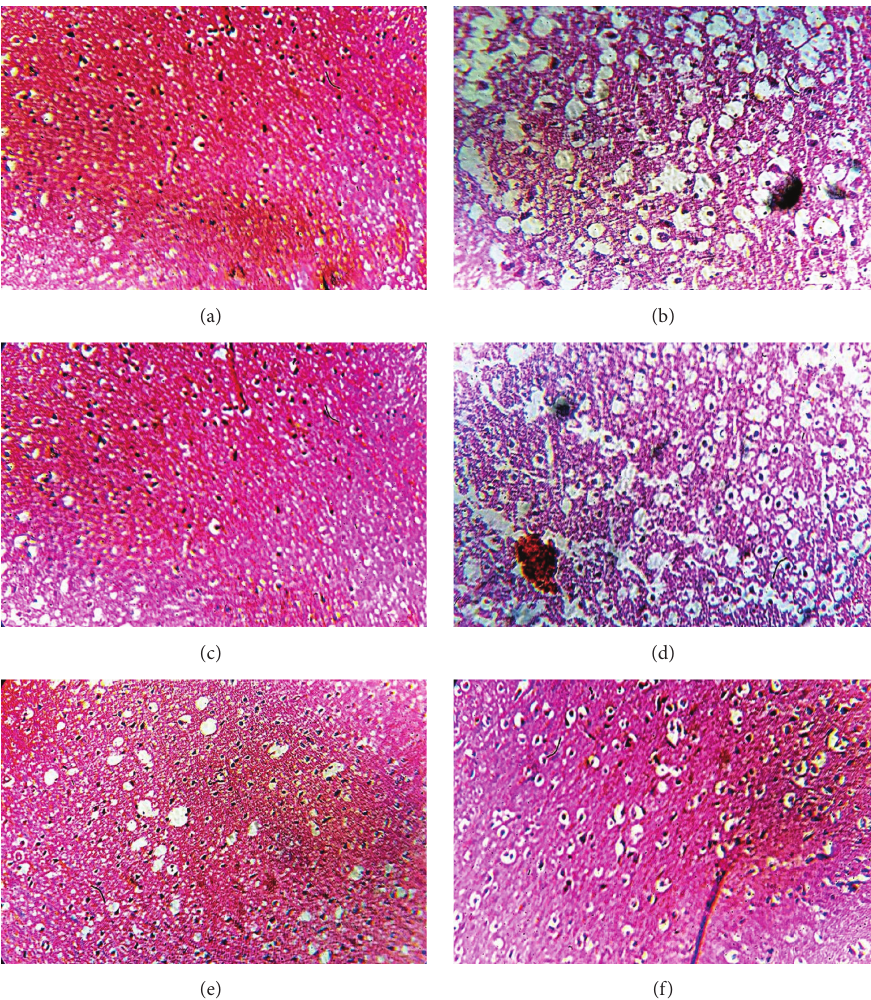
Figure 4: Effect of PEFRE on histopathological changes in the brain of normal and 6-OHDA treated animals (H&E staining; original magnification, 40x). (a) Normal control showing normal brain architecture. (b) Rats treated with 6-OHDA showing degeneration of neurons. (c) Rats treated with 6-OHDA and Levodopa (6mg/kg) showing minimal changes in neuronal cell integrity and architecture. (d) Rats treated with 6-OHDA and PEFRE (100mg/kg) showing mild decrease in neurons and cellular hypertrophy. (e) PEFRE (200 mg/kg) and (f) PEFRE (400mg/kg) treated rats showing minimal changes in neuronal cell